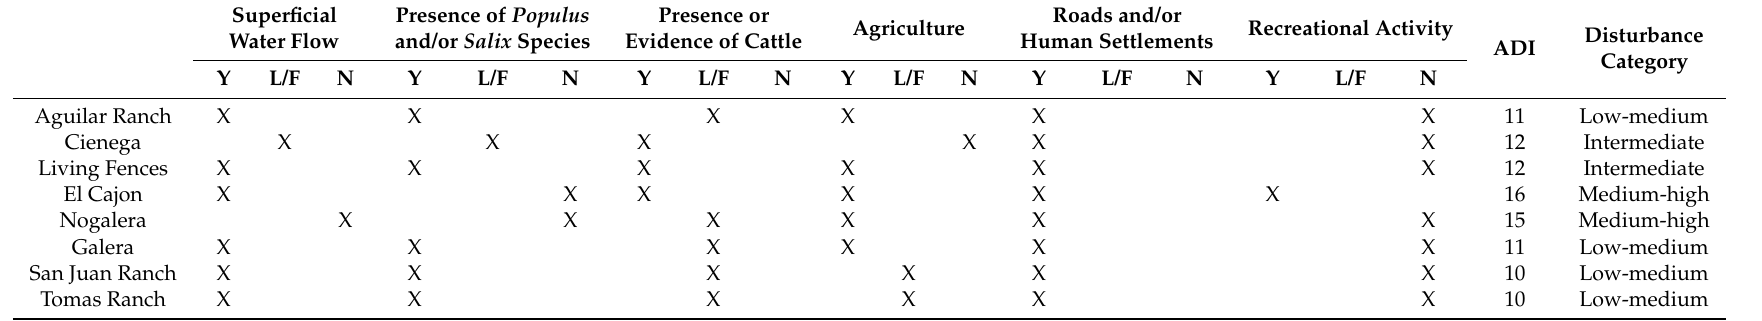
Table 5. Criteria intensity ( Y yes, L/F low or few, N no) registered on each site for derivation of the Anthropogenic-disturbance